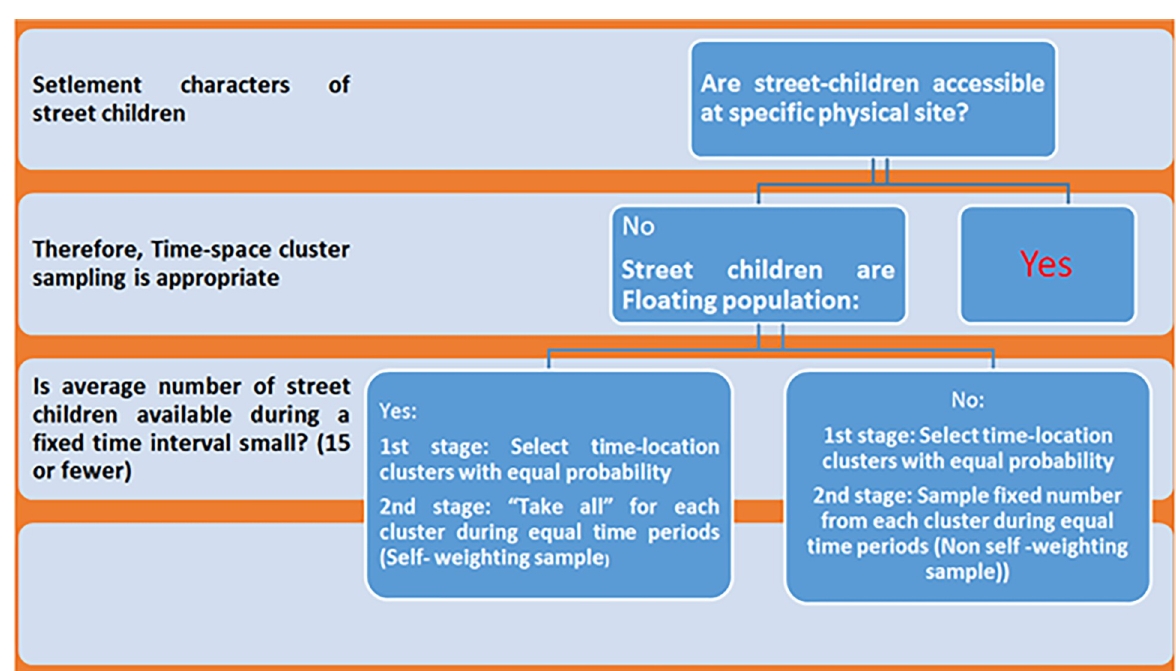
Fig 2. Sampling technique of floating population adapted from repeated behavioral surveys in populations at risk of HIV, Family Health International, 2000.